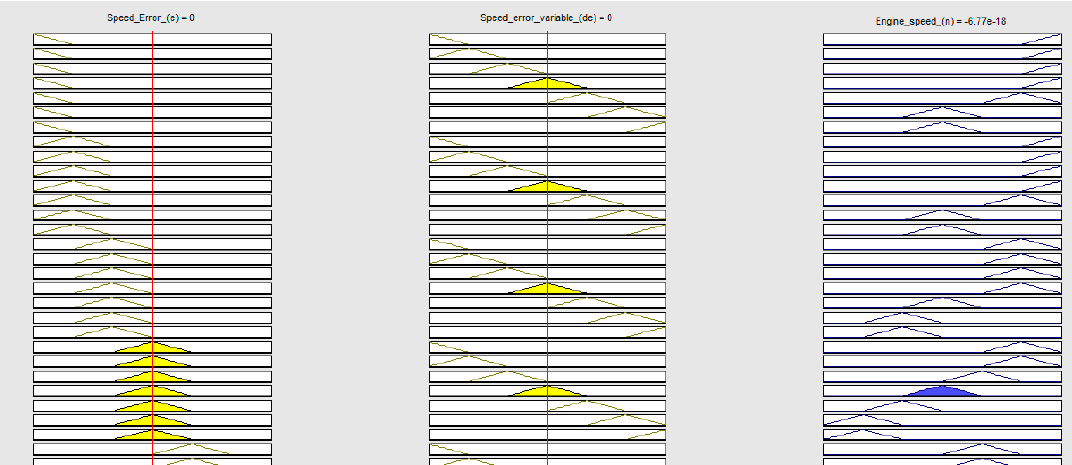
Figure 7. Diesel engine speed control rules.